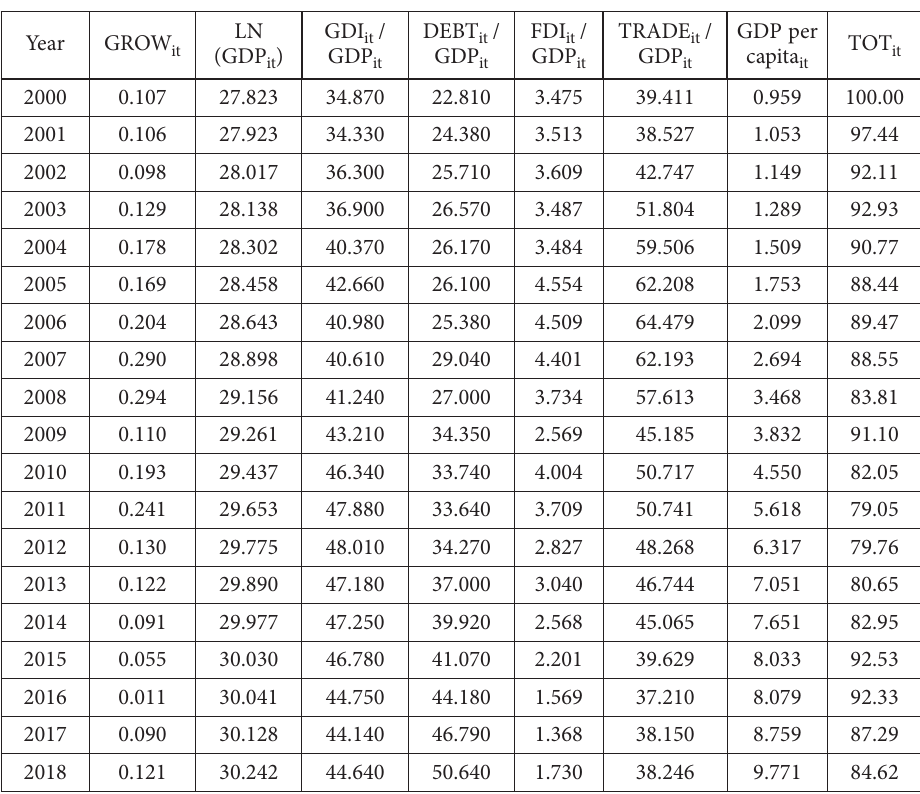
Table A2. Basic input data for the model (5), (6) (source: elaborated based on World Trade Organiza- tion, 2020; World Bank, 2020; Ukraine National Debt, 2020; The Global Economy, 2020; Ukraine